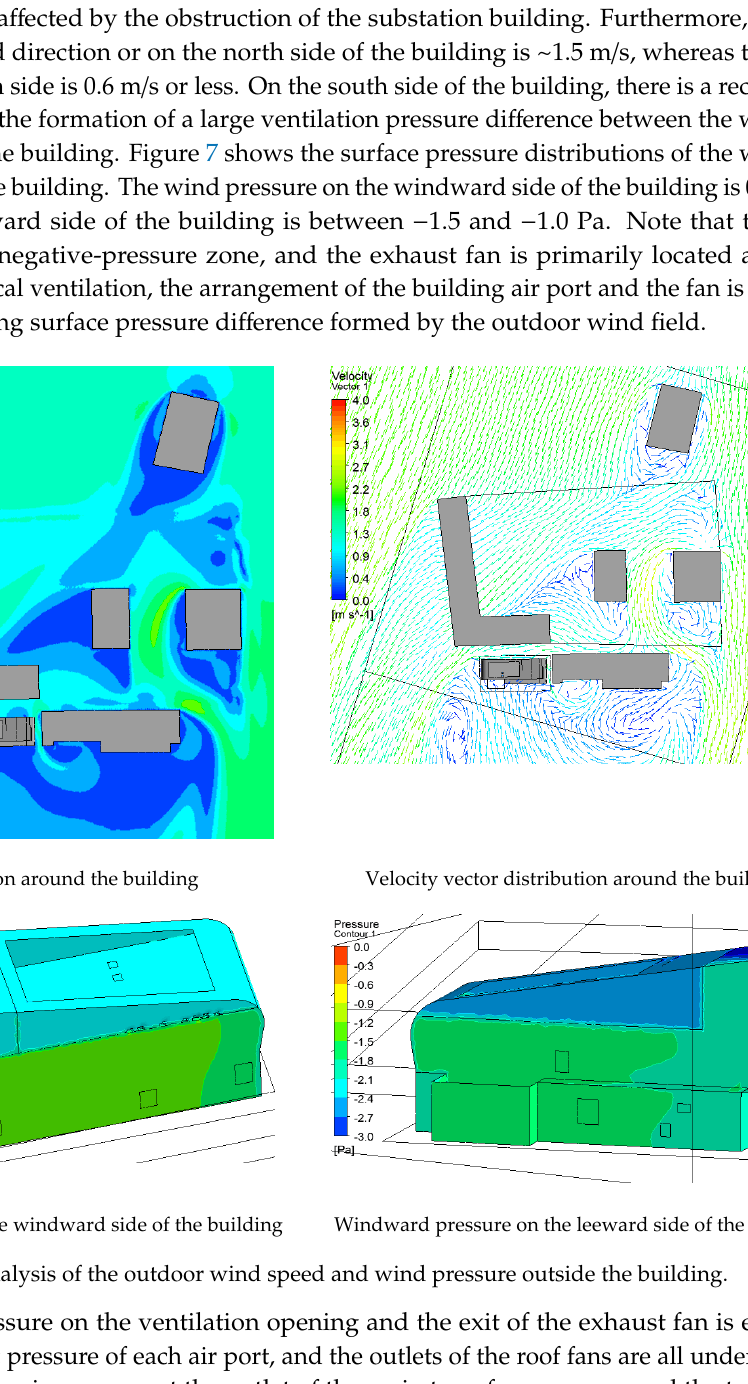
Figure 6. Grid analysis of local and overall areas of outdoor buildings.